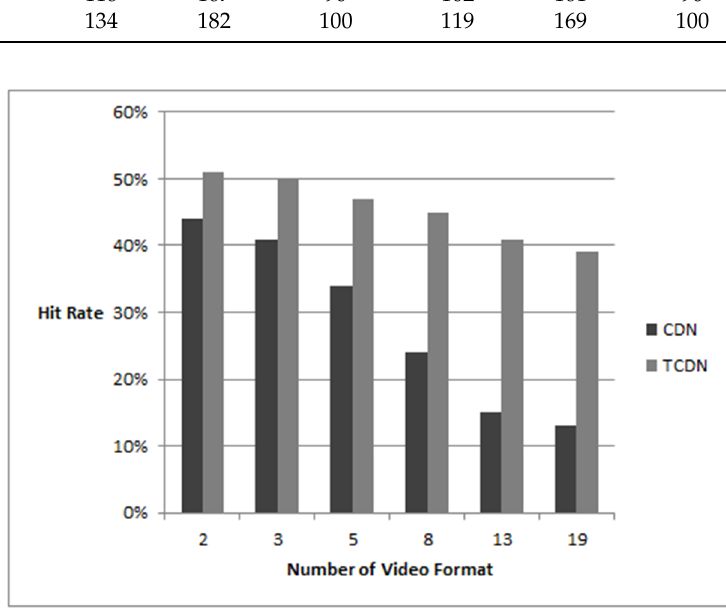
Figure 6. Hit rate column contrast